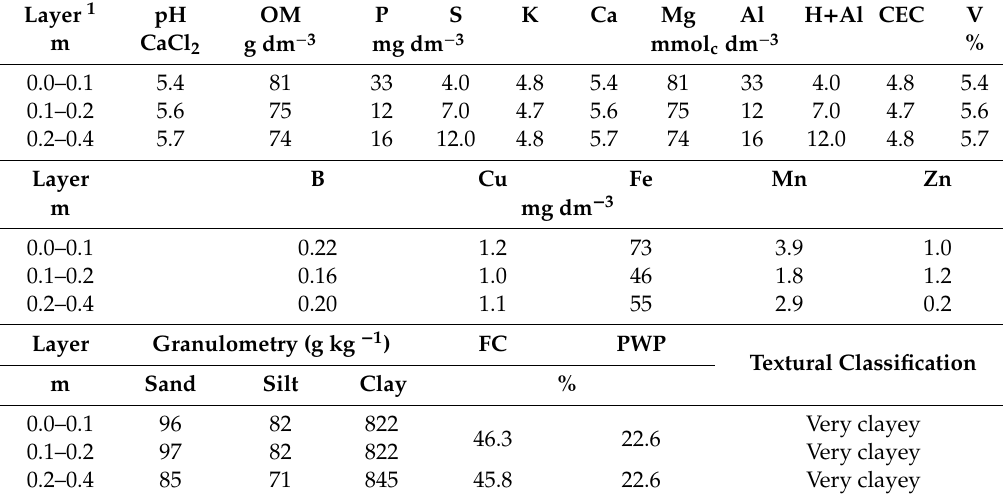
1 For soil determinations, soil samples with undeformed structure were collected in Uhland rings of 6.34 cm in diameter and 5 cm in height. FC: Field capacity; PWP: permanent wilting point; P, K, Ca, and Mg: Resin; S: